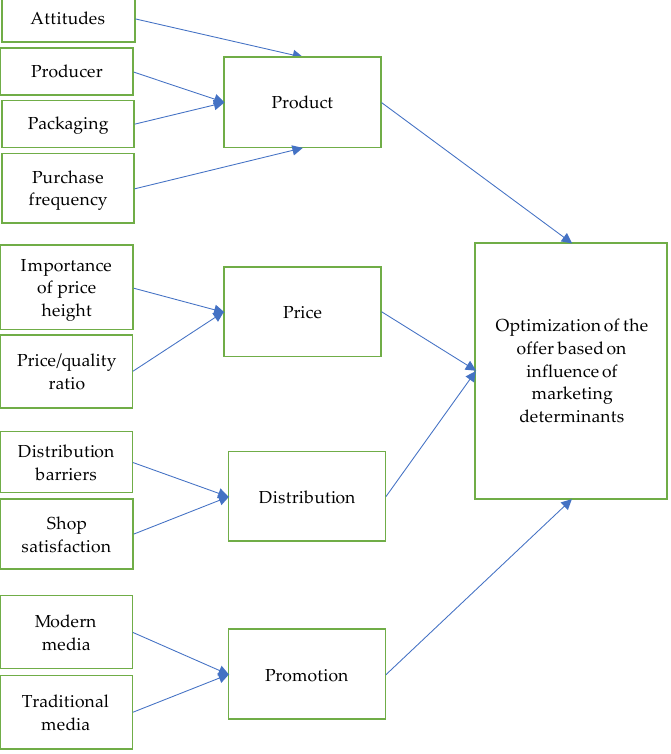
Figure 1. Conceptual model of